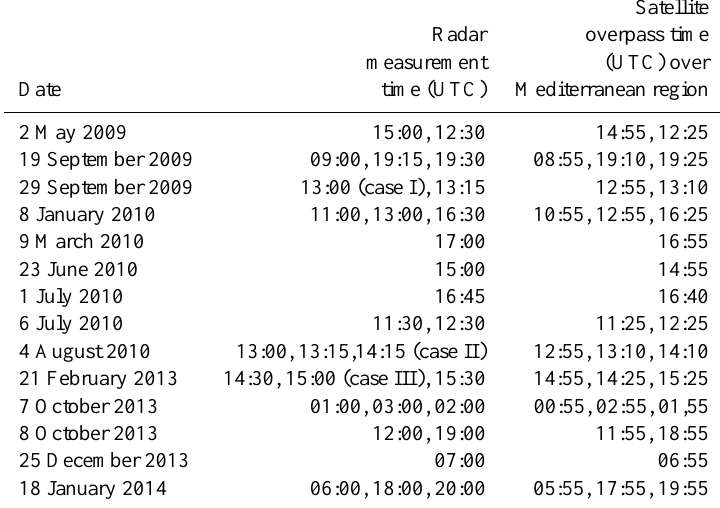
Table 8. List of case studies used for validation.